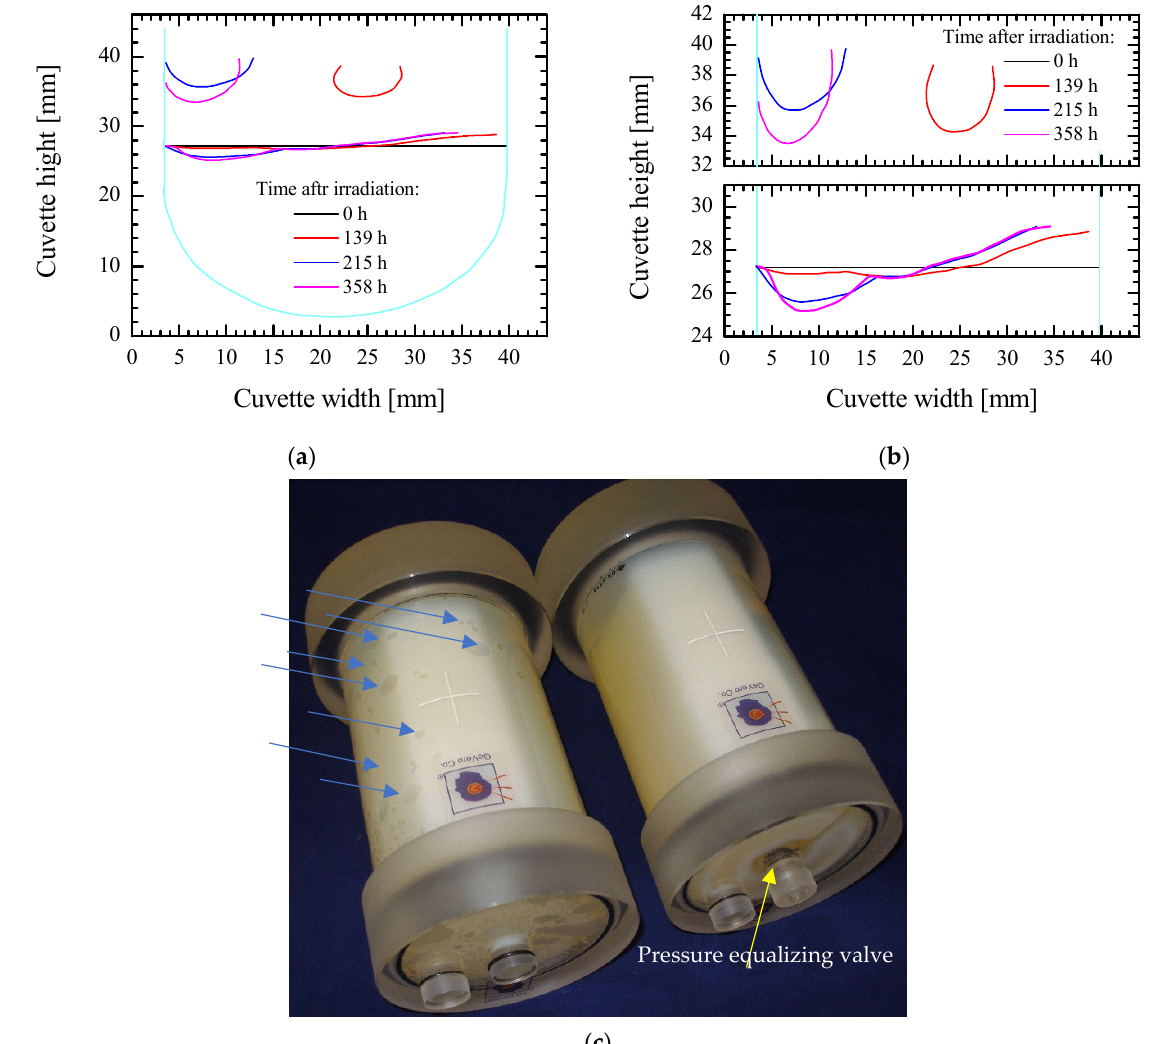
Figure 7. Evolution of the white line in the VIC-T dosimeter (see Figure 6c ‒ e) corresponding to the polymerized monomers when exposed to green laser light (532 nm, 2 mW) (Figure 6a,b). The results obtained during storage relate to the autopolymerization of the entire volume of the VIC-T dosimeter after absorbing green laser light quanta scattered from the white line polymer ( a , b ). The three parabolic lines at the top of the graph correspond to the concave areas at the top of the VIC-T cuvette. Below are the lines corresponding to the white line of polymerized VIC-T monomers. At 0 h the white line was straight; in long times the line was bending. The cyan lines correspond to the walls of the cuvette; ( a ) the graph represents the dimensions of the entire cuvette; ( b ) the graph is drawn with a different OY range for better inspection of the white line bend. In ( c ), an exemplary polymer gel dosimeter (VIP) in two nearly identical containers (GeVero, Co., Poland) is shown after irradiation (ionizing radiation): the left container is without a pressure equalizing valve; the right container is equipped with an internal pressure equalizing valve. The blue arrows indicate the number of cavities formed during storage in the left valveless container that are not present in the valve container.